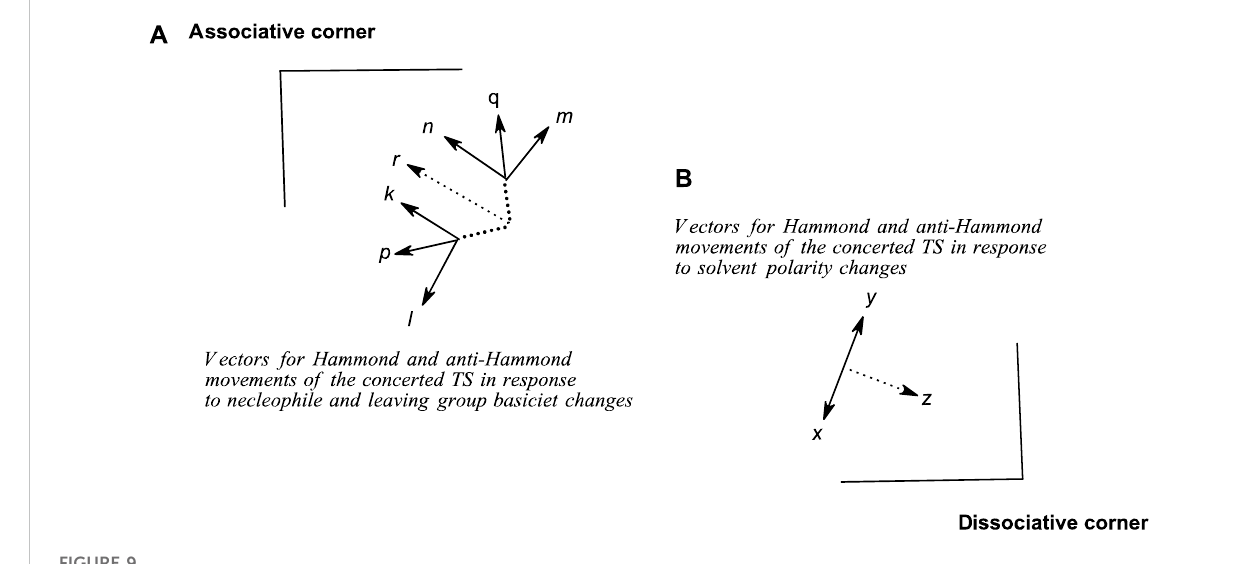
FIGURE 9 A schematic diagram showing Hammond and anti-Hammond vectorial movements of the concerted TS in response to changes in (A) nucleophile and leaving group base strengths and (B) solvent polarity.